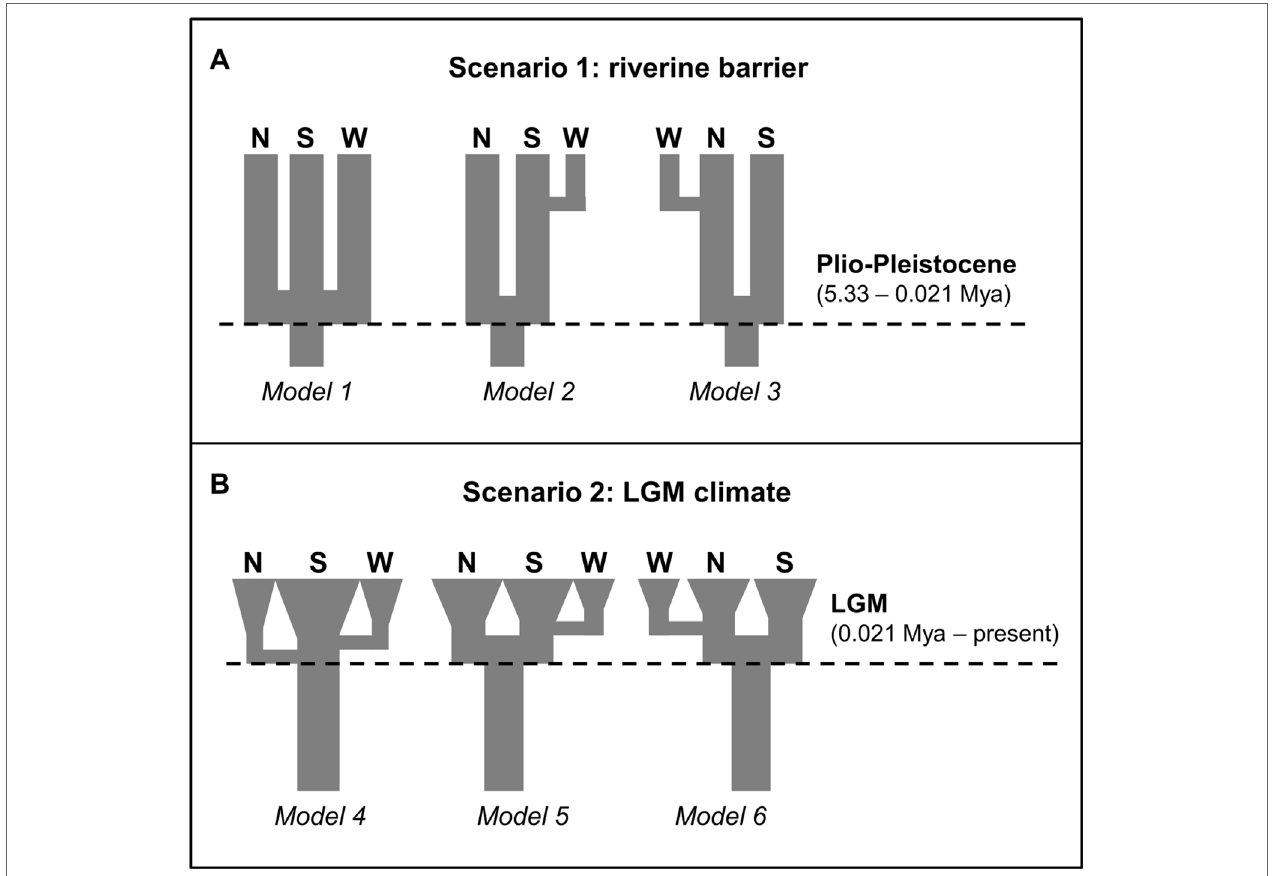
FIGURE 2 | Alternative scenarios for diversification of the P. nordestinus populations of the South, North, and West lineages tested with multilocus approximate Bayesian computation (ABC). (A) Scenario 1 (models 1–3), the divergence between the Northern and Southern P. nordestinus populations is related to the relocation of the São Francisco River (SFR) during the Plio-Pleistocene and alternative three models. (B) Scenario 2 (models 4–6), the diversification observed in P. nordestinus is derived from the last glacial cycle as seen modeling in the ENM analysis (see Figure 1 ) (Pleistocene Refuges Hypothesis). See Material and Methods for more